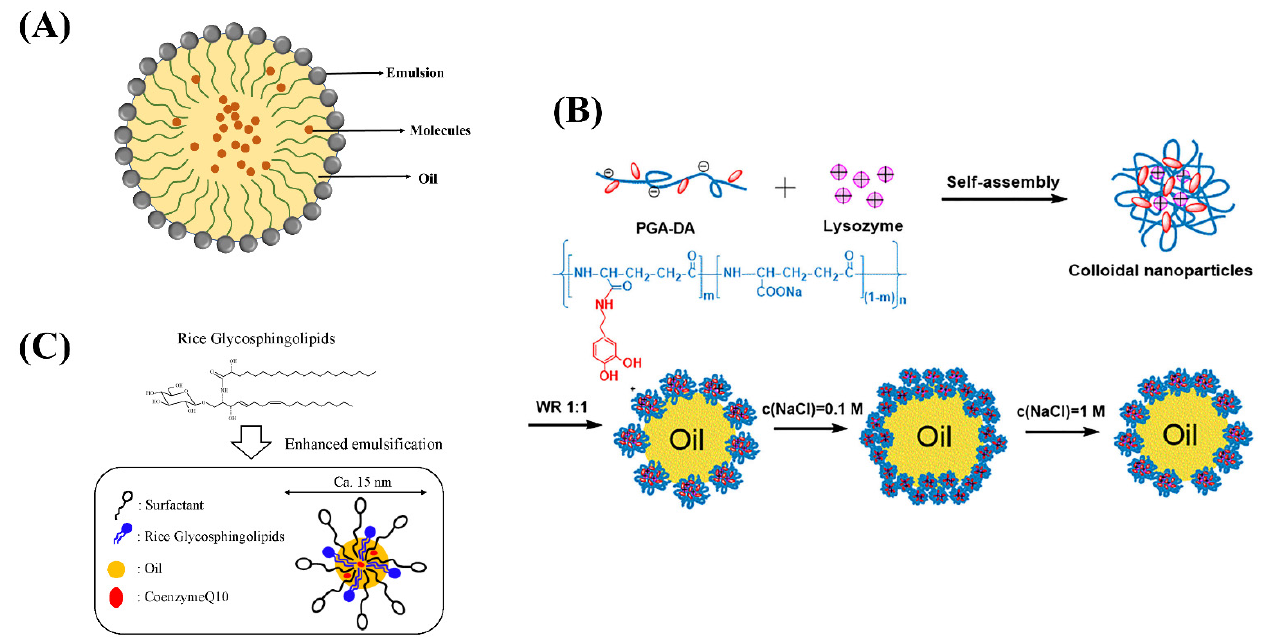
Figure 3. ( A ) The structure of nano-emulsion. ( B ) Schematic depiction of the formation and the oil-in- water interfacial behavior of Lys/PGA-DA colloidal nanoparticles. ( C ) Schematic representation of food grade microemulsion with rice glycosphingolipids.